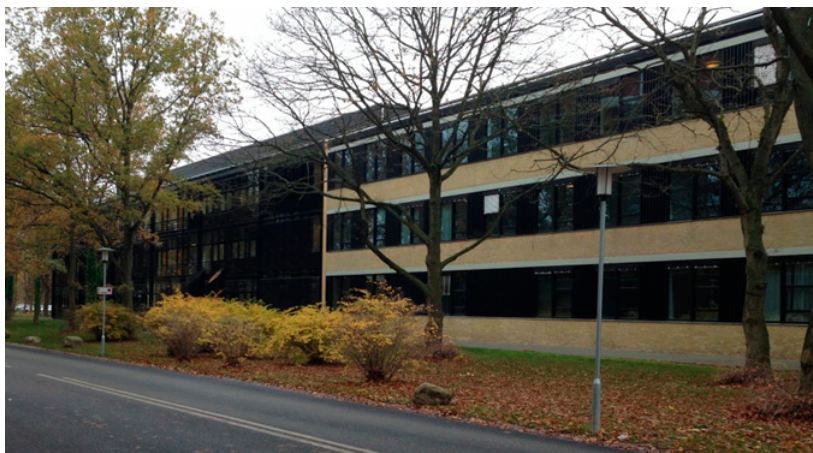
Figure 7. Connectivity between buildings.